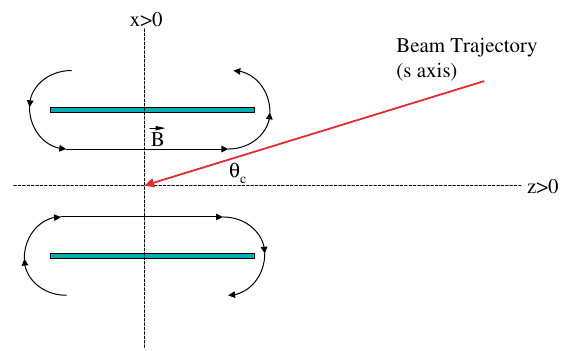
FIG. 1. (Color) Plan view schematic of a beam passing through a solenoid with a horizontal crossing angle.